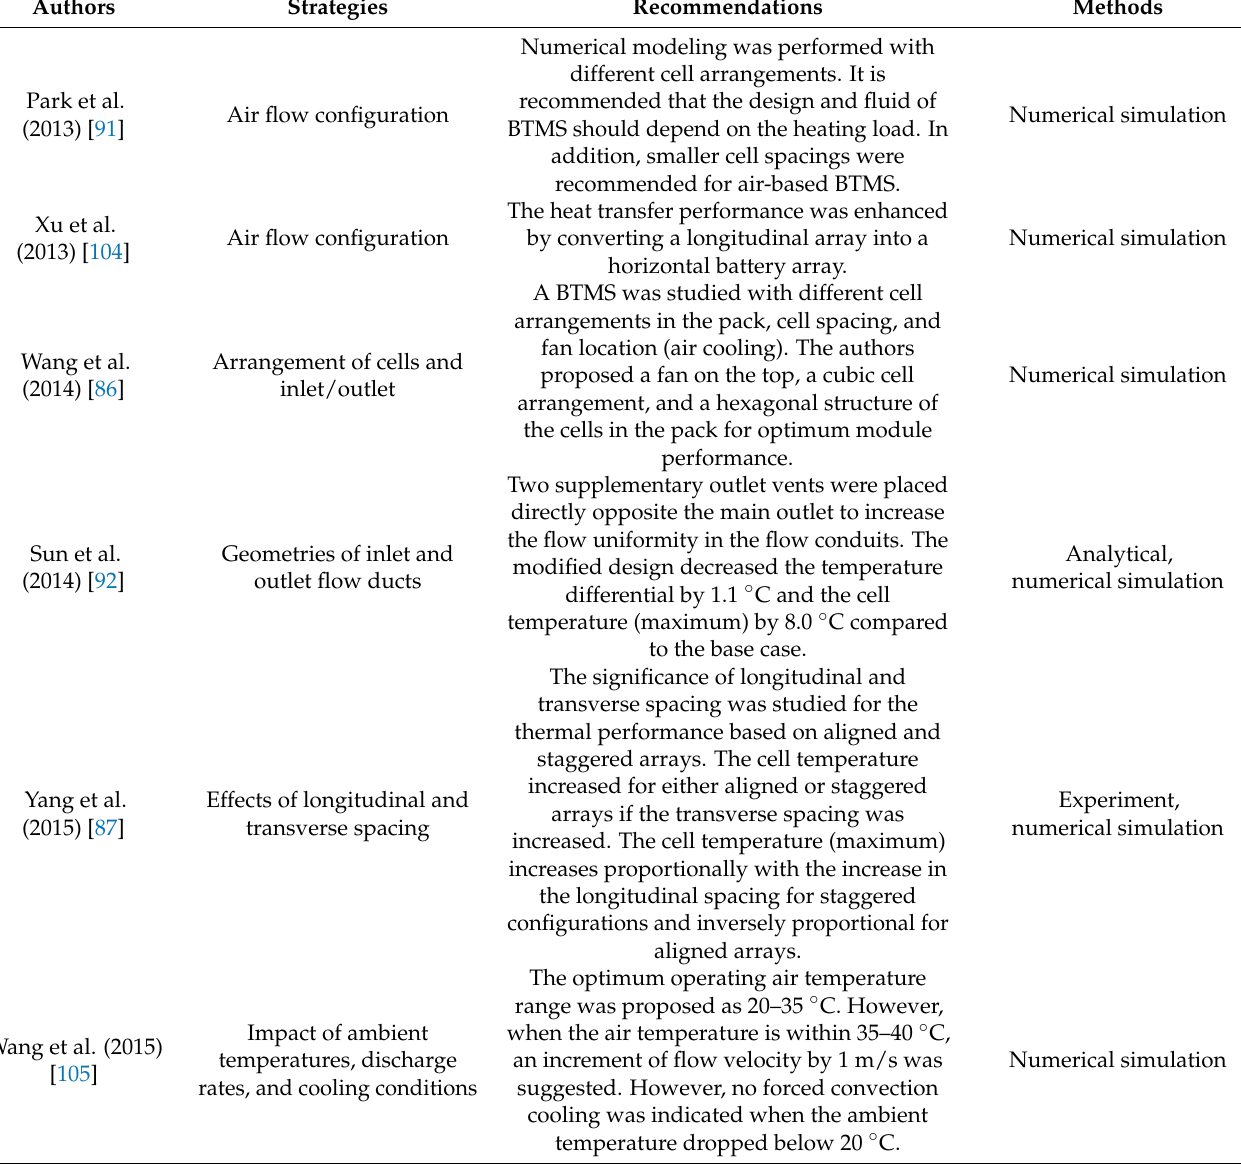
Table 3. Recent developments in air-based battery thermal management